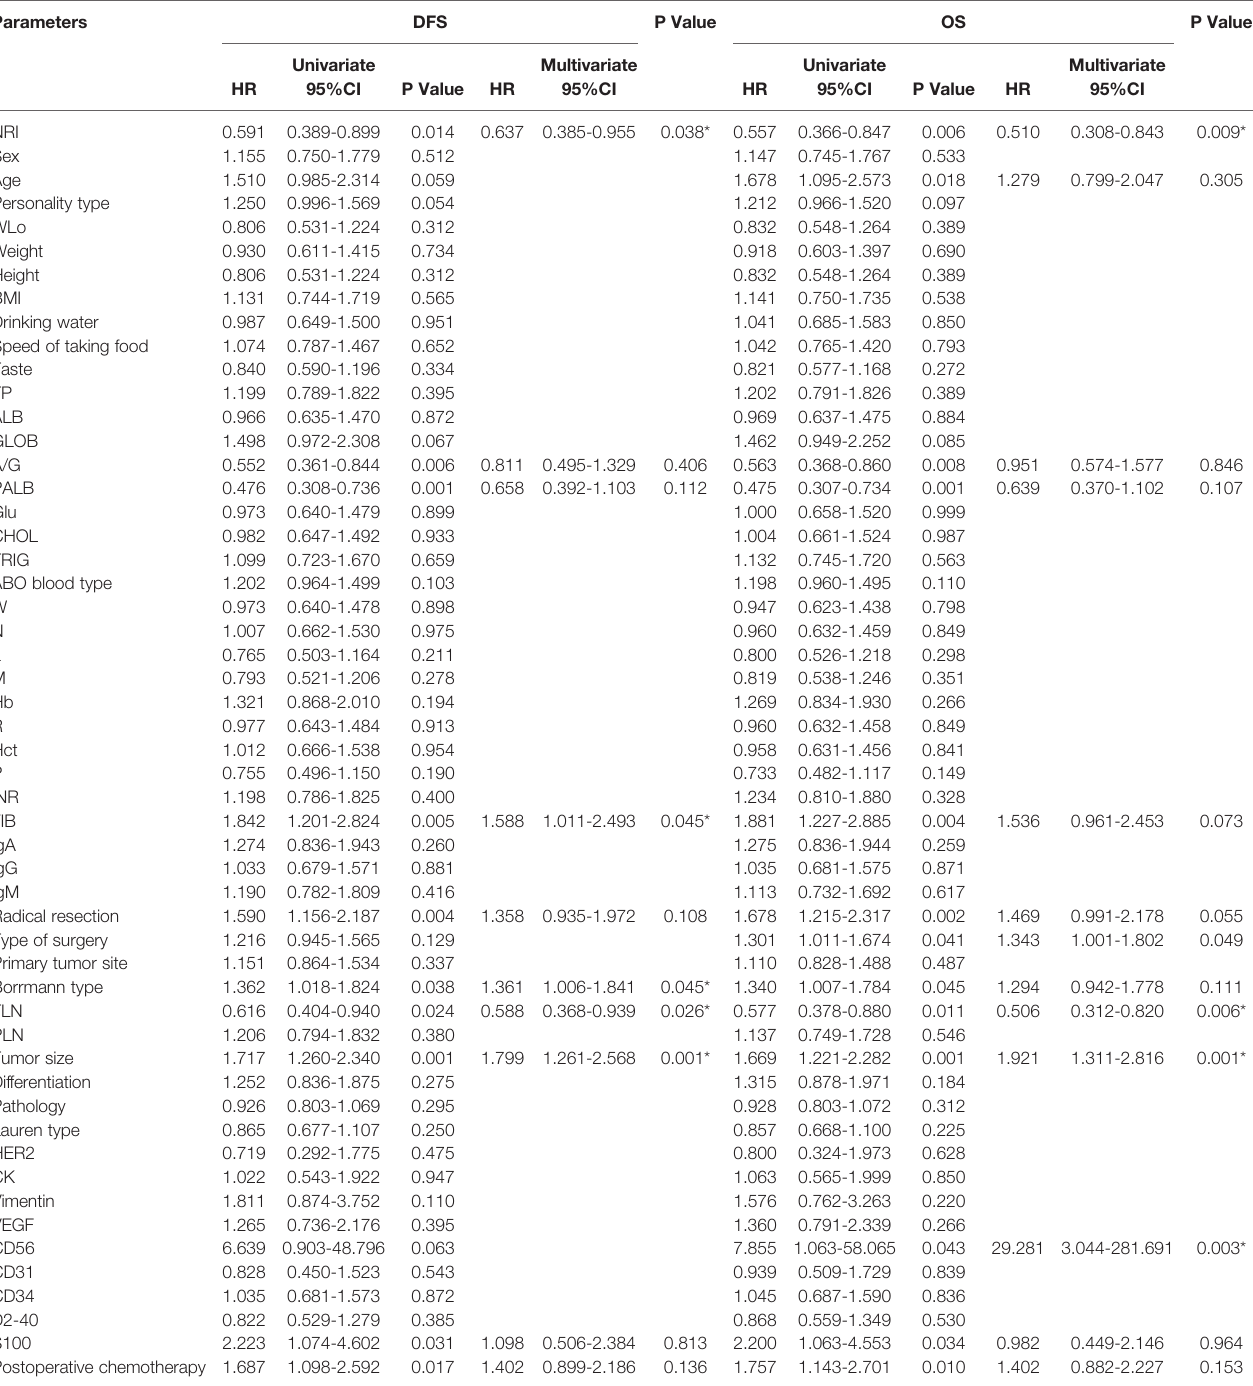
TABLE 4 | Univariate and multivariate analyses on the prognostic predictors in patients with stage III gastric